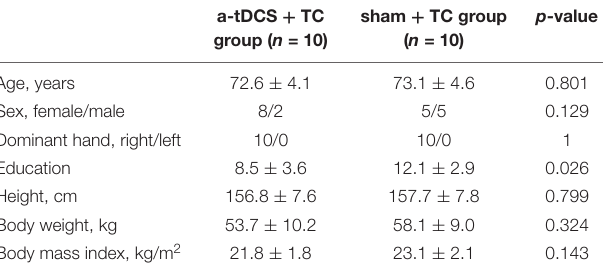
TABLE 1 | Baseline demographic characteristics of patients ( n =